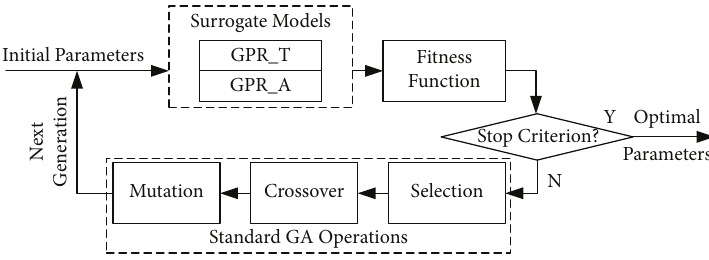
Figure 7: The surrogate model-based parameter optimization